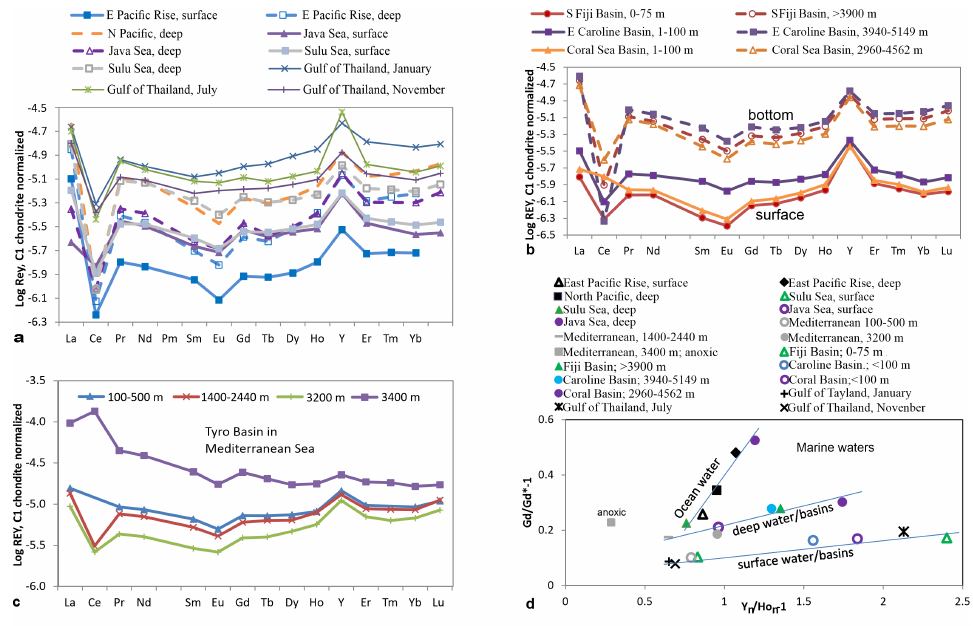
Figure 4. REY in seawater. ( a ) C1-chondrite-normalized rare earths and Y distribution patterns of waters from surface- (solid line) and deep (broken line) water bodies showing changes in REY distribution patterns and corresponding changes of Ce, Gd and Y anomalies. East Pacific Rise [61]; North Pacific [24]; Java Sea (unpublished); Sulu Sea [24]; Gulf of Thailand [2]. ( b ) Oceanic basins build by atolls [62]. ( c ) Tyro sub-basin in the eastern Mediterranean Sea [23]. ( d ) Correlation of Gd and Y anomalies in seawater.